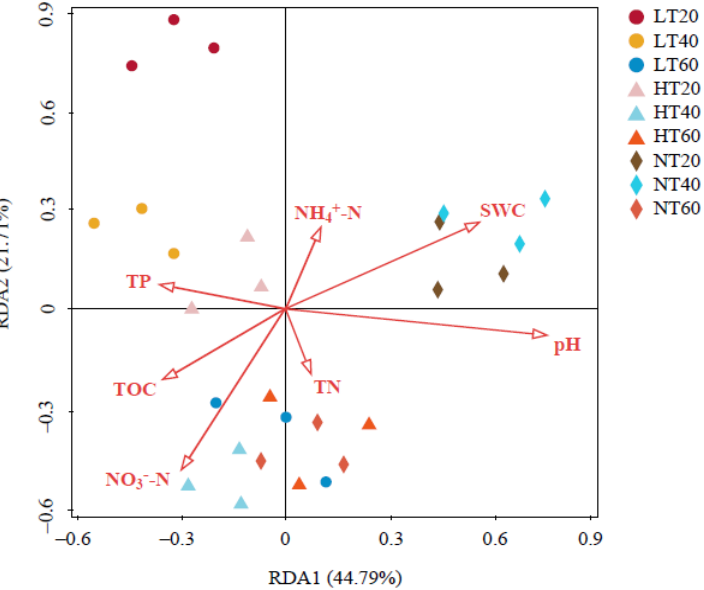
Figure 7. Redundancy analysis (RDA) of the relationship between soil physicochemical properties and bacterial community structure. TOC: total organic carbon; TN: total nitrogen; TP: total phosphorus; NH 4+ -N: ammonium nitrogen; NO 3− -N: nitrate nitrogen; SWC: soil water content.